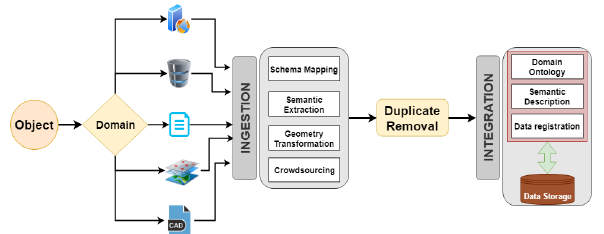
Figure 1. Paradigm of the data fusion